Question: What visual encoding does this figure use to show its data?
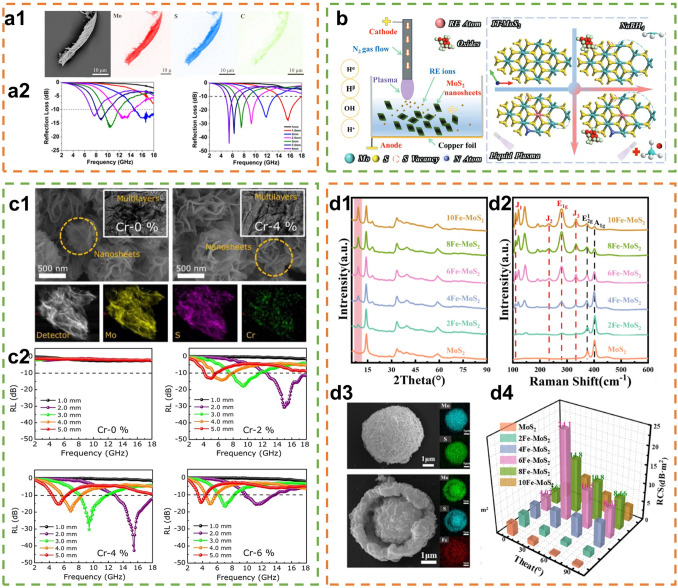
Answer: line